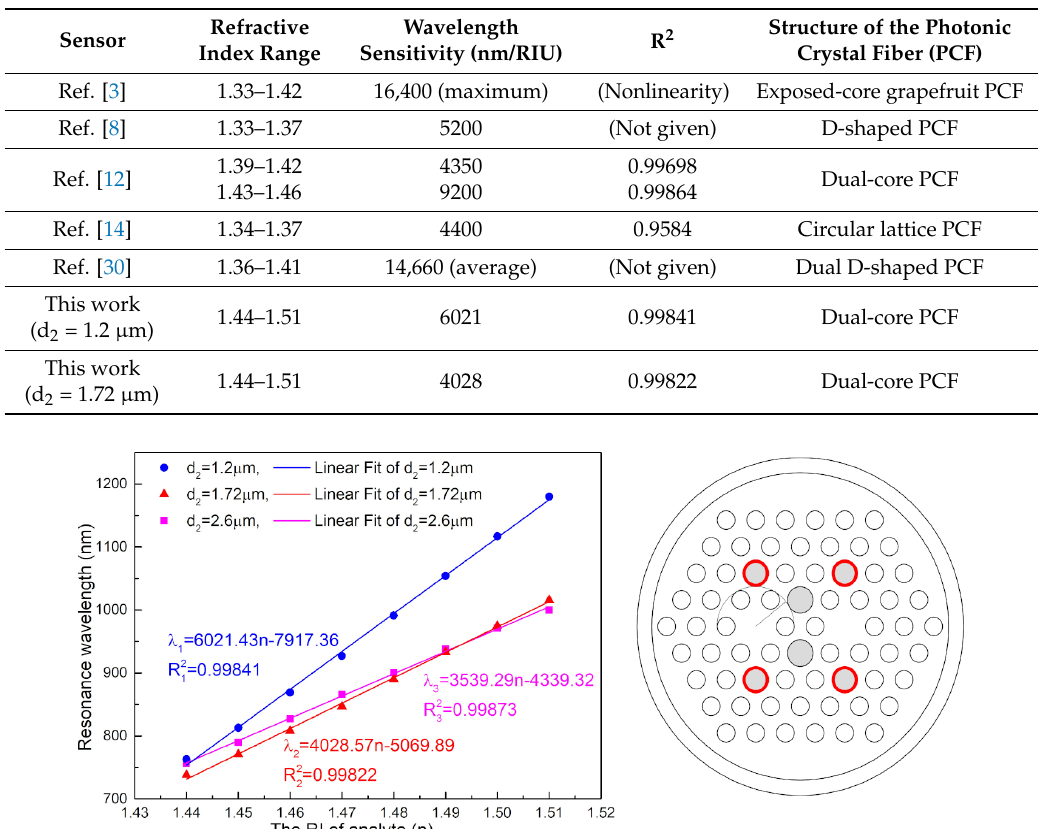
Table 1. Comparison of the proposed sensor with existing sensors.